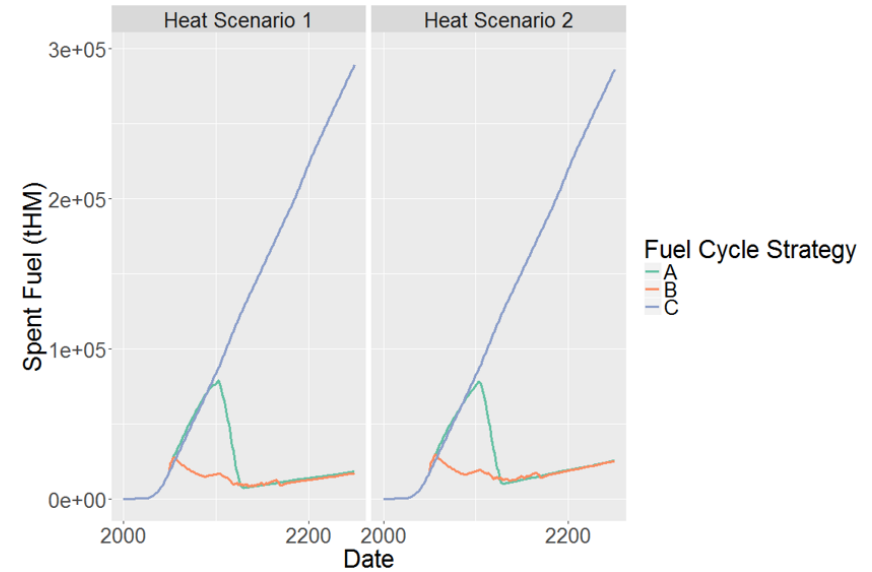
Figure 4. Masses of spent fuel for the different scenarios